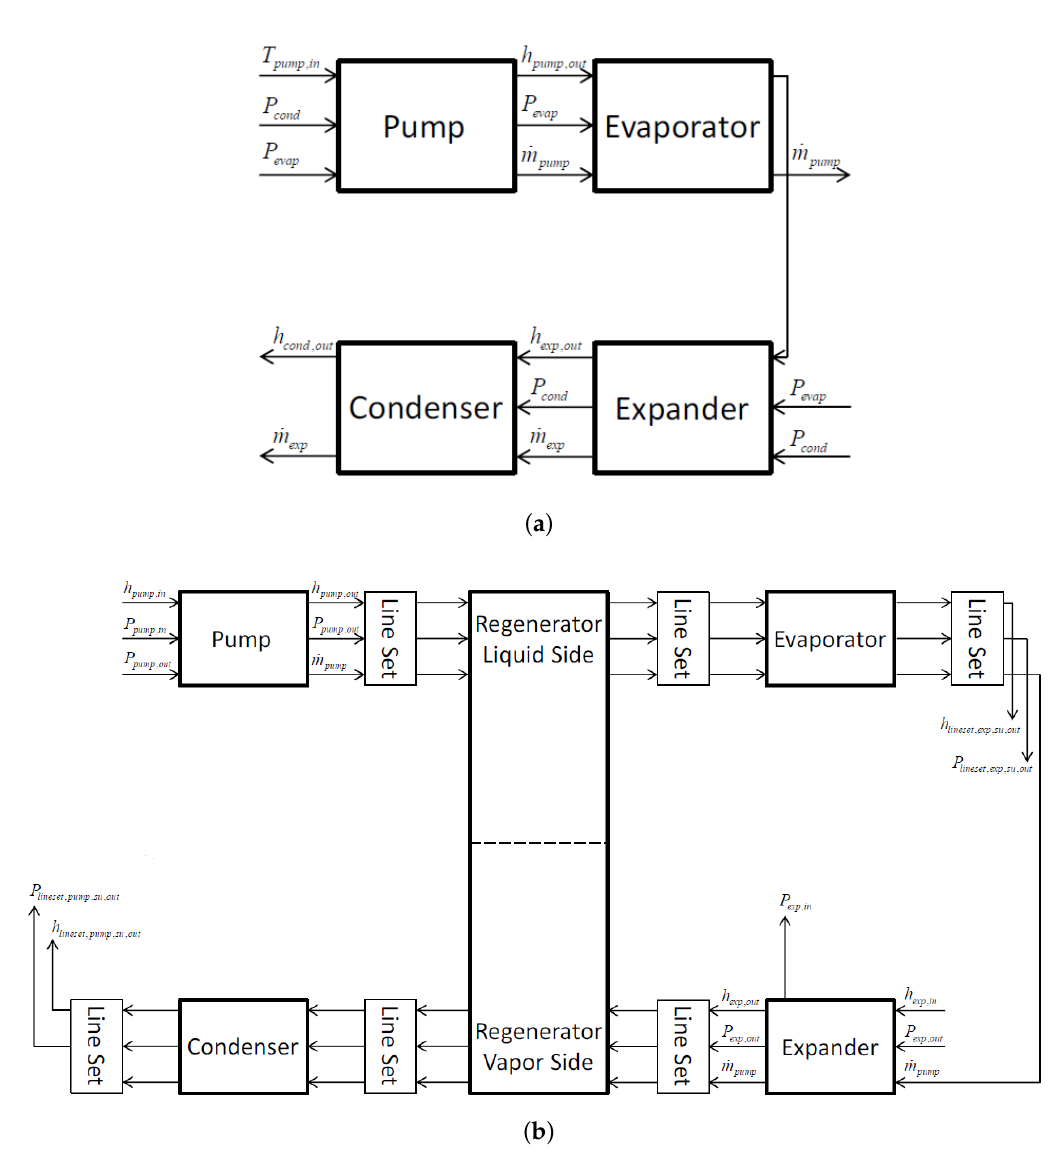
Figure 7. Flow-charts: ( a ) preconditioner loop; ( b ) main solver